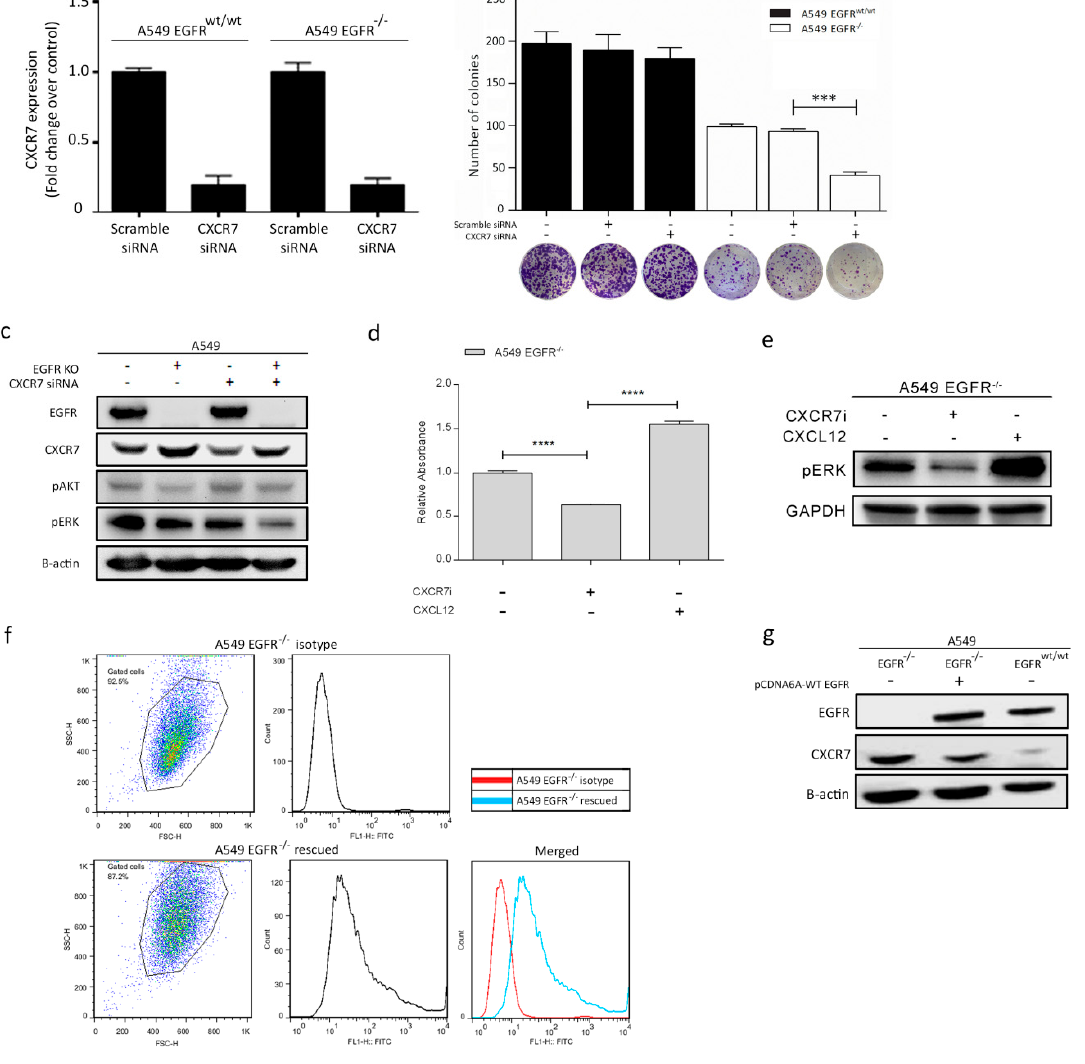
Figure 5. The interaction of EGFR and CXCR7 and their effect on downstream pathways and cell proliferation in A549 EGFR wt/wt and EGFR − / − cells. ( a ) CXCR7 mRNA levels after transient transfection with either scramble siRNA or CXCR7 siRNA. ( b ) Colony formation assay to determine the effect of CXCR7 knockdown on cell proliferation. ( c ) Western blot analysis of CXCR7, pAKT, and pERK protein expression levels after CXCR7 knockdown. ( d ) Colony formation assay to determine the effects of the CXCR7 inhibitor and CXCL12 on cell proliferation. ( e ) Western blot analysis of pERK after treatment of EGFR − / − cells with CXCR7 inhibitor (2 μ M) for 24 h and CXCL12 (100 ng/mL) for 3 min. ( f ) FACS analysis shows EGFR expression in A549 EGFR − / − following transfection with EGFR pCDNA. ( g ) Western blot analysis of EGFR and CXCR7 in A549 EGFR − / − cells transfected with EGFR pCDNA, EGFR − / − , and EGFR wt/wt cells. Data in bar graphs are represented as mean ± SD ( n ≥ 3); two- tailed unpaired student’s t -test: * p -values < 0.05; ** p -values < 0.01; *** p -values < 0.001; ns: not significant. 3.7. Rescue of EGFR Leads to CXCR7 Downregulation in A549 EGFR − / − Cells To further confirm the interaction between EGFR and CXCR7, we rescued EGFR in A549 EGFR − / − - cells. Overexpression of wild-type EGFR in A549 EGFR − / − cells restored EGFR membrane expression (Figure 5f). In the control groups, EGFR signals were not detected. Interestingly, CXCR7 expression dramatically decreased after the reintroduction of EGFR to levels slightly above those in EGFR wt/wt cells (Figure 5g). These data suggest a tight functional regulatory link between EGFR and CXCR7.